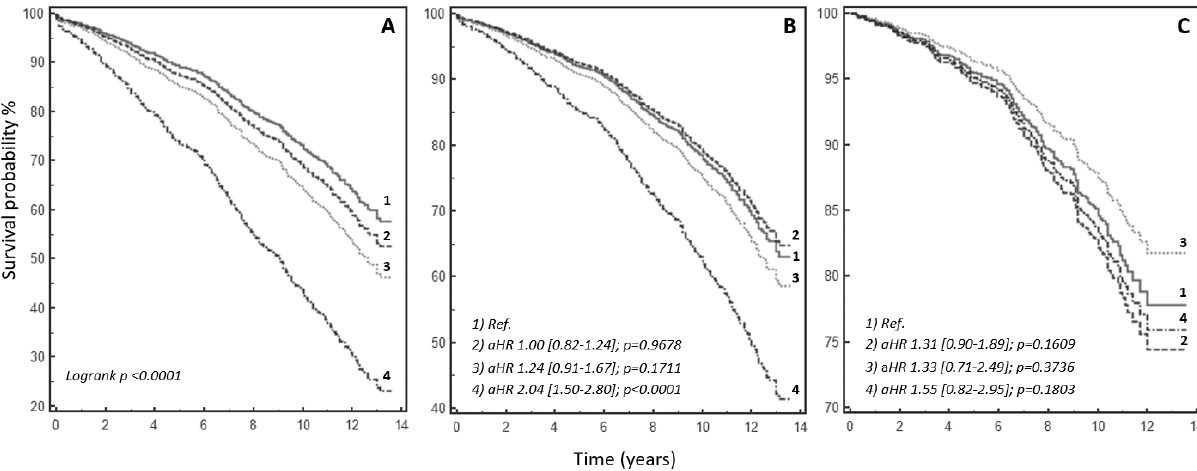
Figure 2. Survival analysis. ( A ) Kaplan–Meier survival curves for study subgroups. ( B ) Age-adjusted survival curves (Cox proportional-hazards model). ( C ) Fully adjusted (for all the clinical variables which proved statistically significant in the multivariable model) survival curves (Cox proportional-hazards model). Legend: (1) patients who never developed AF (control group), (2) patients with no history of AF before surgery in whom POP AF was clinically detected (new-onset POP AF), (3) patients with pre-surgical history of paroxysmal/persistent AF, and (4) permanent AF patients. Comparisons between different study subgroups are reported as hazard ratios (HR) and related 95% confidence intervals [squared brackets], and p -values as assessed in both univariable and multivariable analyses. POP AF: post-operative atrial fibrillation.